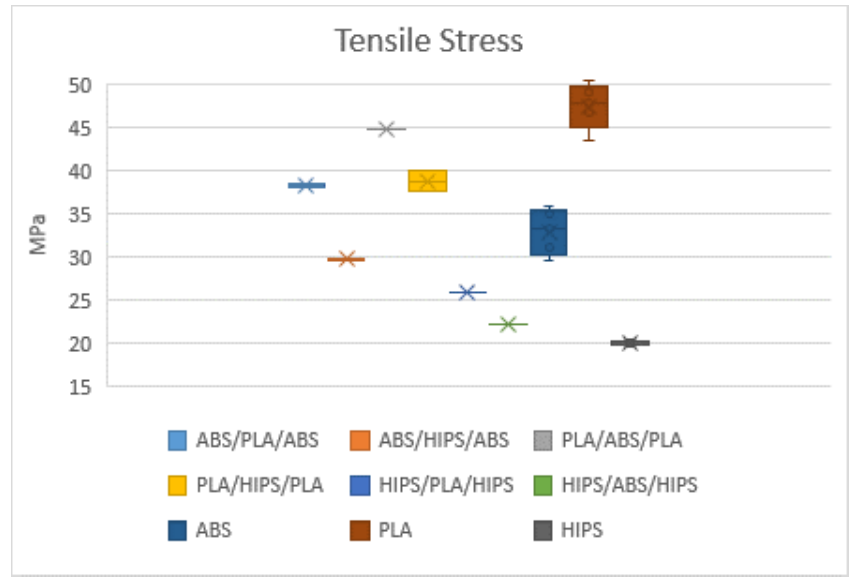
Figure 5. Mean tensile stress of all specimen tested.